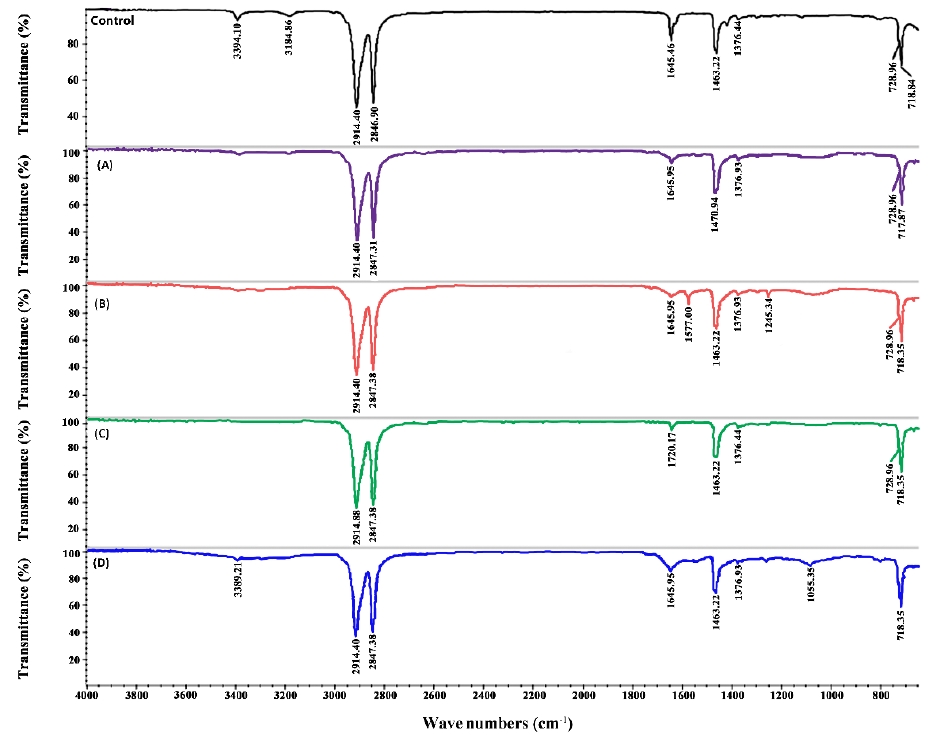
Figure 5. Fourier-transform infrared spectroscopy (FTIR) of epixylon (EPX) showing new and vanished peaks of PE under Pb 2+ (M1) and Cd 2+ (M2) concentration of 50 mg/L (C2): ( A ) EPX + 13 C + peaks of PE under Pb 2 + (M1) and Cd 2 + (M2) concentration of 50 mg / L (C2): ( A ) EPX + 13 C + M1C2 M1C2 + PE, ( B ) EPX + 13 C + PE, ( C ) EPX + 13 C + M2C2 + PE, and ( D ) EPX + NAM + PE.